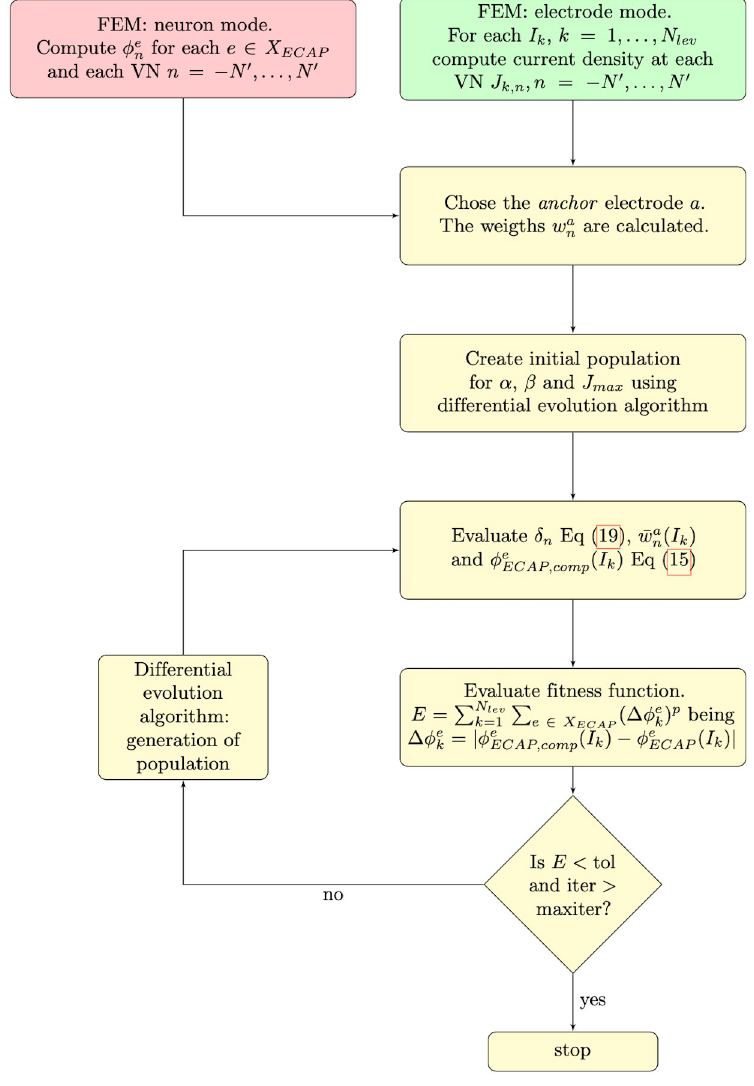
Fig 9. Flowchart of the